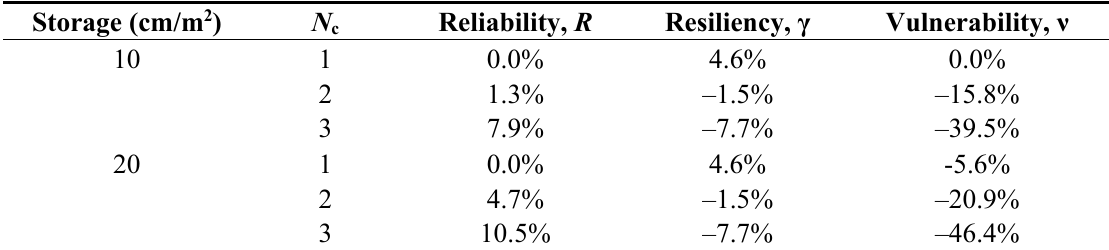
Table 6. Percentage changes in the performance criteria for the climate change rainfall data (2070–2099) for